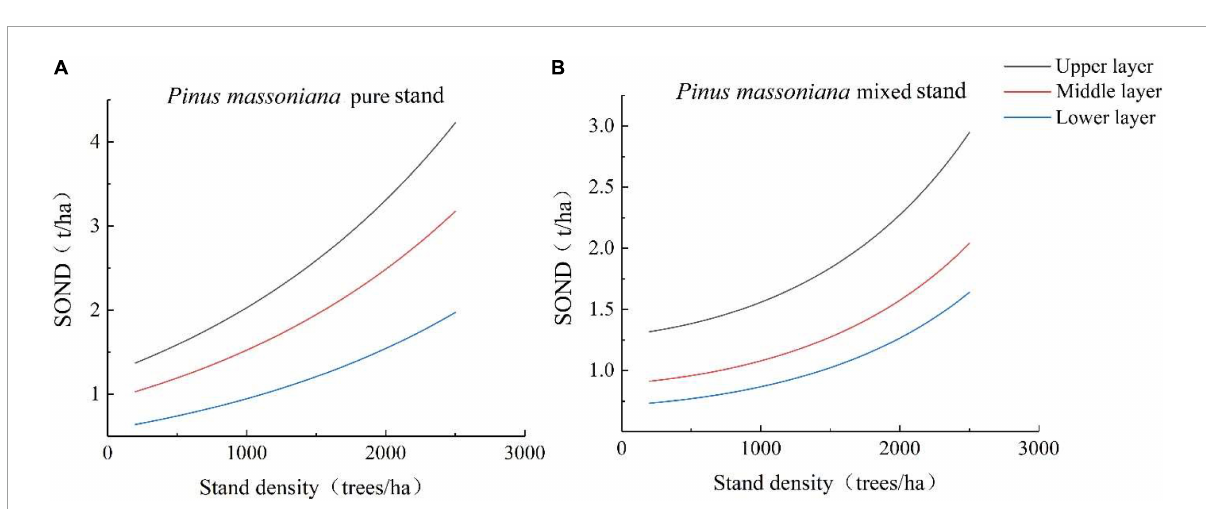
FIGURE2 Storage (SOND) at different depths and stand densities. (A) SOND at different depths and stand densities in pure P. massoniana stands; (B) SOND at different depths and different stand densities in mixed P. massoniana